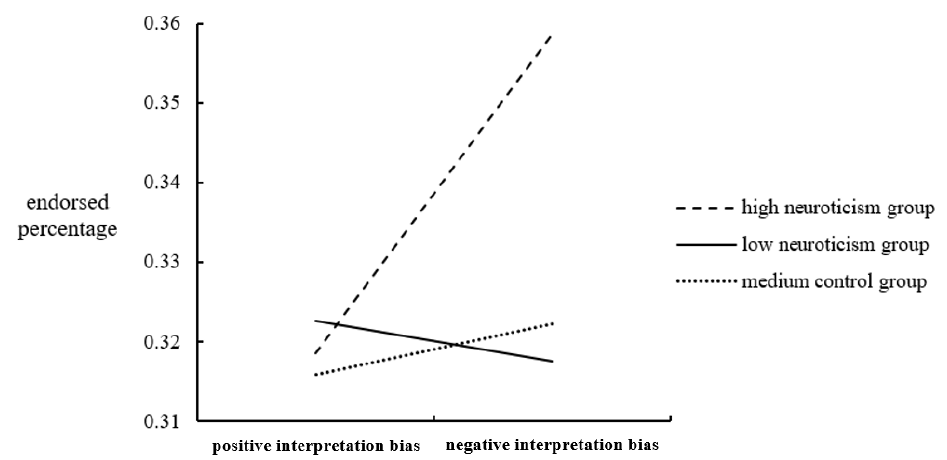
Figure 7. Interaction between interpretation bias type and neuroticism group.